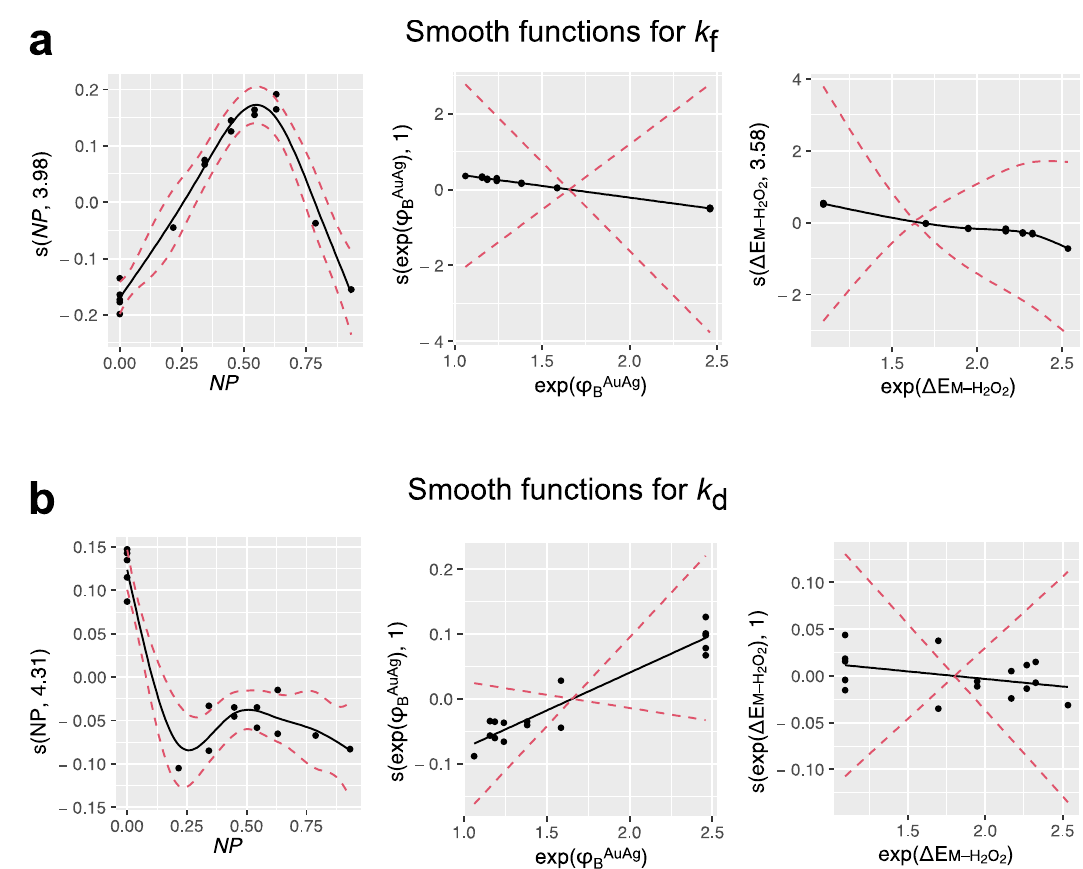
Figure 3. Fitted smooth functions (solid lines) for ( a ) k f and ( b ) k d illustrate relationship between the input and target variables of the GAM models. Dots represent the data, while the dashed red lines indicate the confidence intervals.